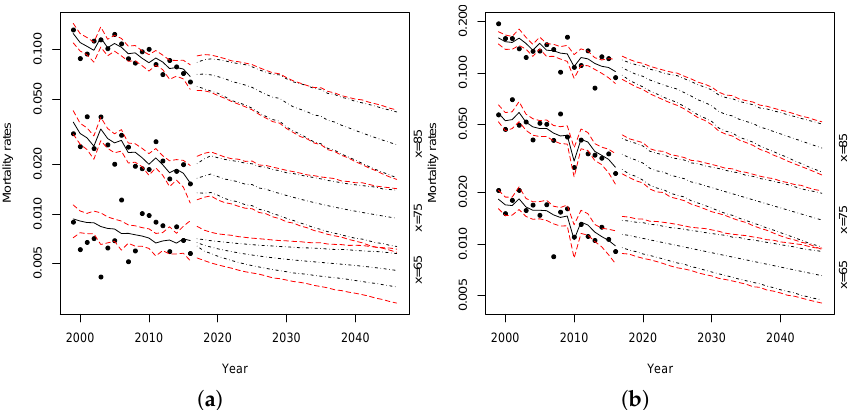
Figure 15. Mortality rate projections at age 65, 75, 85 with parameters uncertainly with RH–LC model for ( a ) female Maltese population, ( b ) male Maltese population.